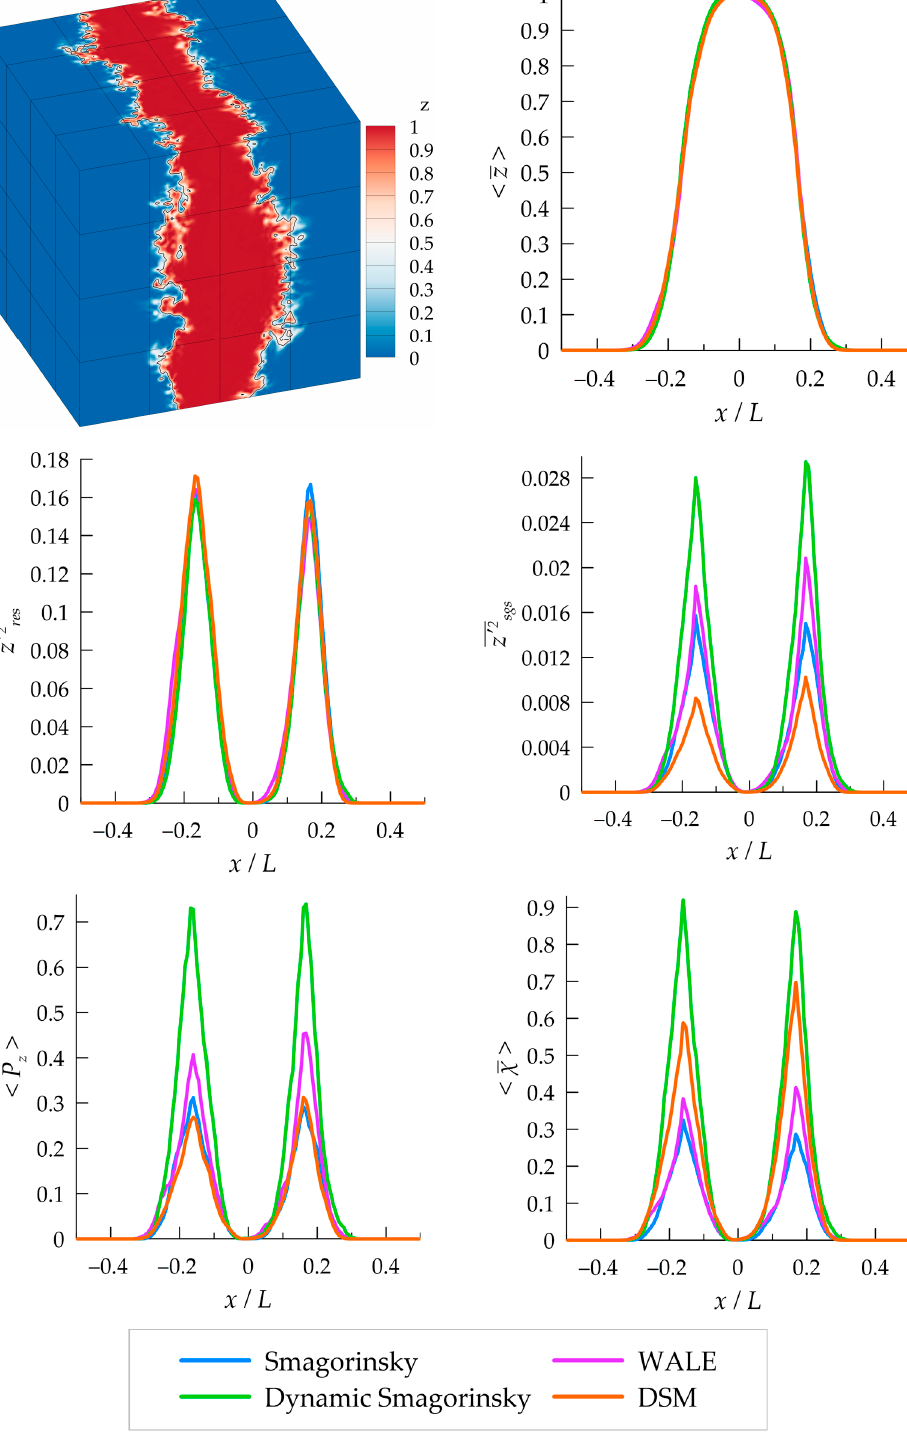
Figure 8. Time instance 𝑡 = 0.05𝑇 (cid:2868) . Designations as in Figure 7.